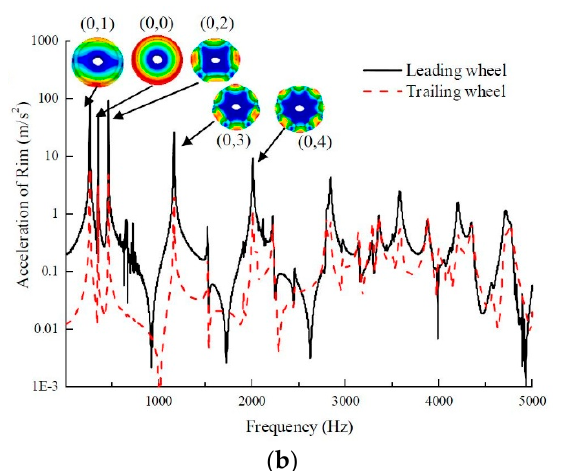
Figure 9. Acceleration of leading wheel and trailing wheel in ( a ) time domain and ( b ) frequency